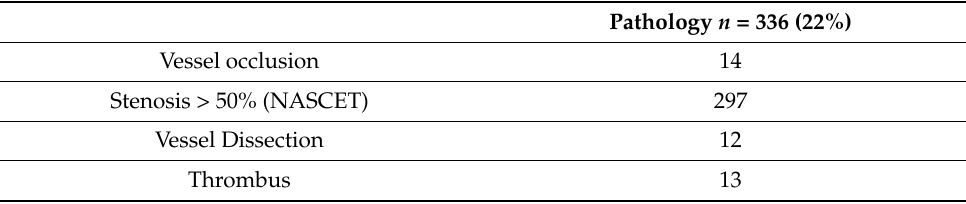
Table A1. Pathology (NASCET North American Symptomatic Carotid Endarterectomy